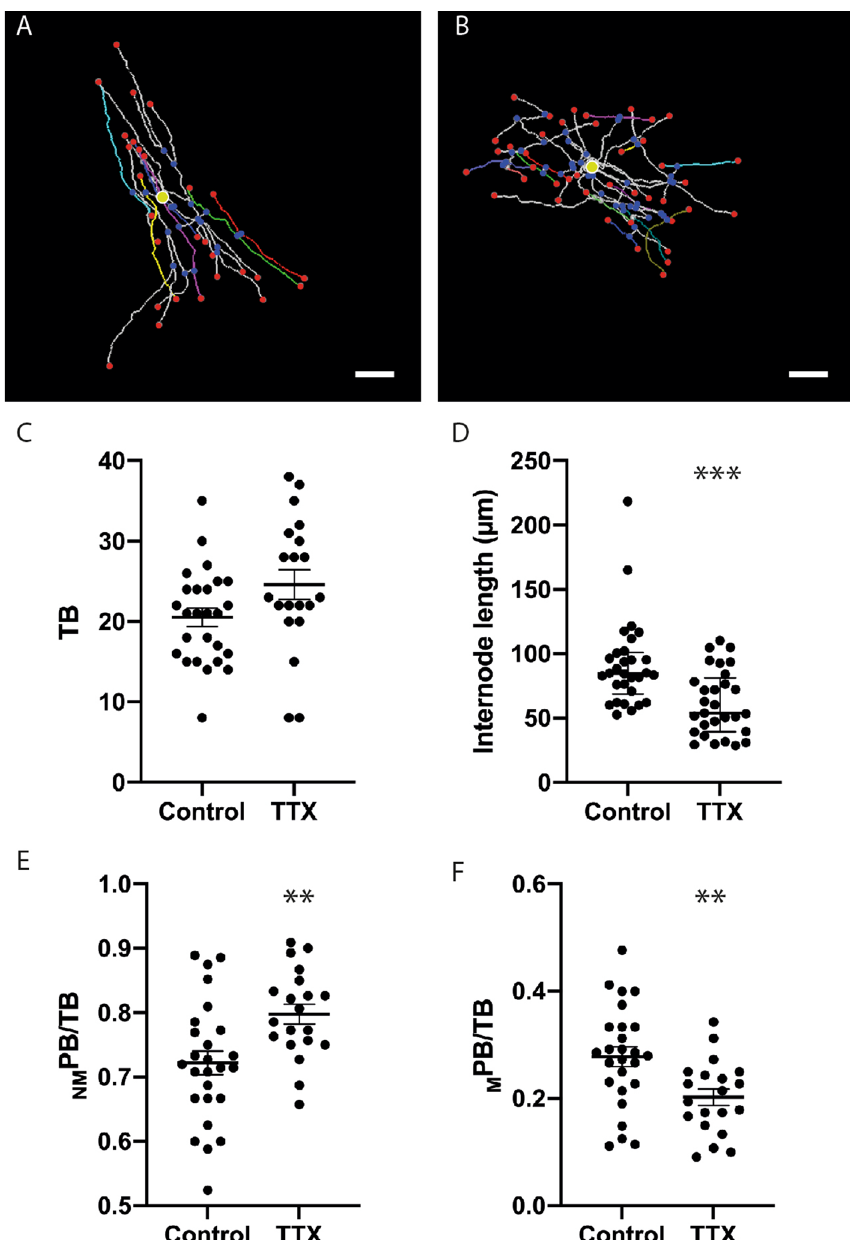
Figure 6. Sustained inhibition of neuronal activity alters OL morphology. ( A , B ) Representative 3-D reconstructions of OL from control ( A ) and TTX ( B ) treated cerebellar slices showing internodes selected for quantification ( A cyan, blue, green, red; B blue, green, red) and cell bodies (yellow circles). ( C ) Tendency towards an increased numbers of branches per cell for TTX treated T OL (Control 20.5 ± 1.15, TTX 24.6 ± 1.86). ( D ) TTX treatment reduced the median internode length of T OL (Control 84.7 µm (68.6–101), TTX 53.8 µm (39.3–81.2). ( E , F ) TTX treatment induced complementary changes in the ratio NM PB/TB ( E ) (Control 0.72 ± 0.02, TTX 0.80 ± 0.02) and M PB/TB ( F ) (Control 0.28 ± 0.02, TTX 0.20 ± 0.02). Scale bars in ( A ) and ( B ) 20 µm. ** Significance P < 0.01, *** Significance P < 0.001. In ( A ) and ( B ) red and blue spheres indicate segment end-point and junction points respectively. Yellow circles indicate position of cell body. Data in ( C ), ( E ) and ( F ) expressed as means ± SEM, data in ( D ) expressed as median ± interquartile